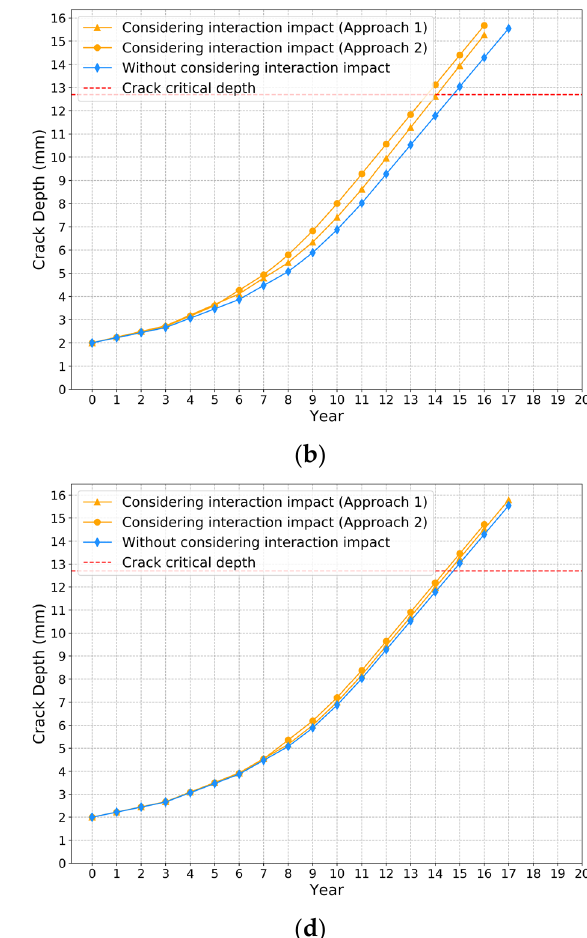
17 of 22 Figure 12. The comparison of SIF results based on approach 2. Corrosion depth d : ( a ) 4 mm; ( b ) 6 mm; ( c ) 10 mm; ( d ) Comparison results for different corrosion depths when crack depth a is 6 mm. The crack propagation models are built based on the proposed XGBoost model and Paris’ law. The crack initial depth is set at 2 mm, since SIF interaction impact ratio is rela- tively large when crack depth is small. The corrosion initial depth is assumed at 6 mm. Figure 13a–d show the comparison results of crack depth growth models for different ax- ial distances between two defects using approach 1 and 2, respectively. The red dash lines represent the crack critical depth, which is approximately 80% of the wall thickness. When the crack depth exceeds the crack critical depth, it is considered a failure. The comparison results shown in Figure 13 indicate that the crack depth predicted by approach 2 reaches the threshold more quickly than approach 1. The comparison results of the crack depth propagation curves for different axial distances based on approach 2 are shown in Figure